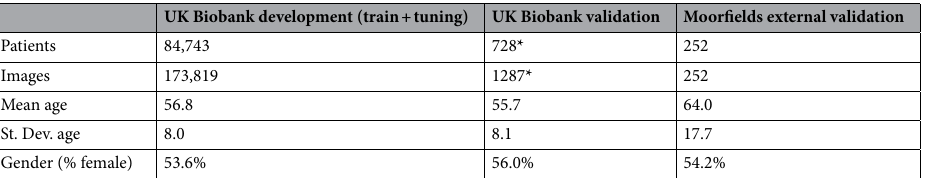
Table 3. Dataset characteristics of UK biobank and moorfields external validation sets. * Numbers reported are post-removal of ungradable